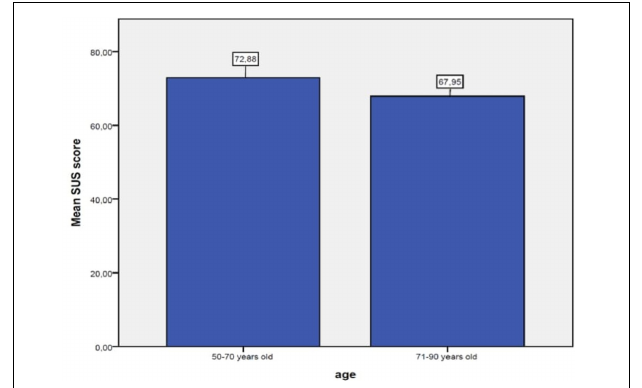
FIGURE 3 | SUS score mean by